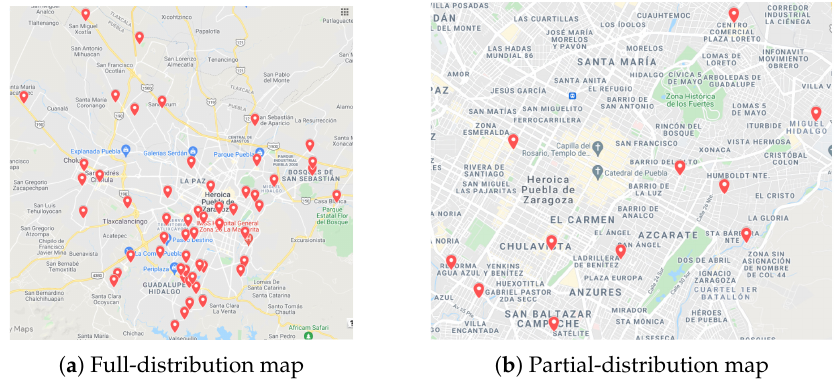
Figure 8. Distribution of deliveries in the city of